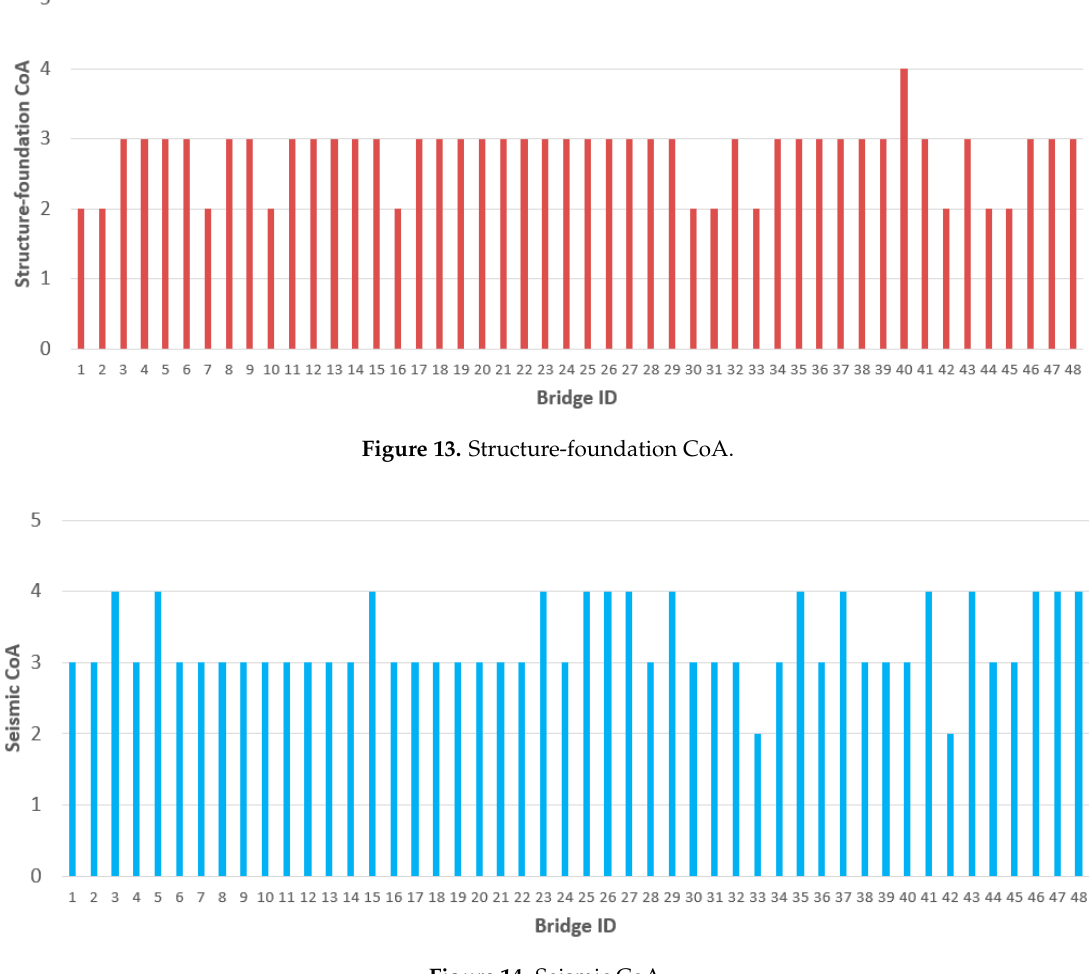
Figure 14. Seismic CoA. Infrastructures 2021 , 6 , x